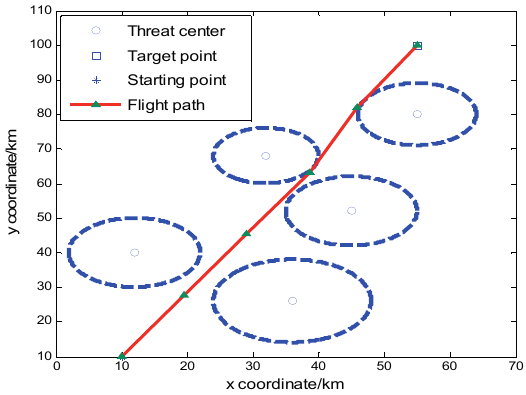
Figure 3. Result of the first instance for D = 5.